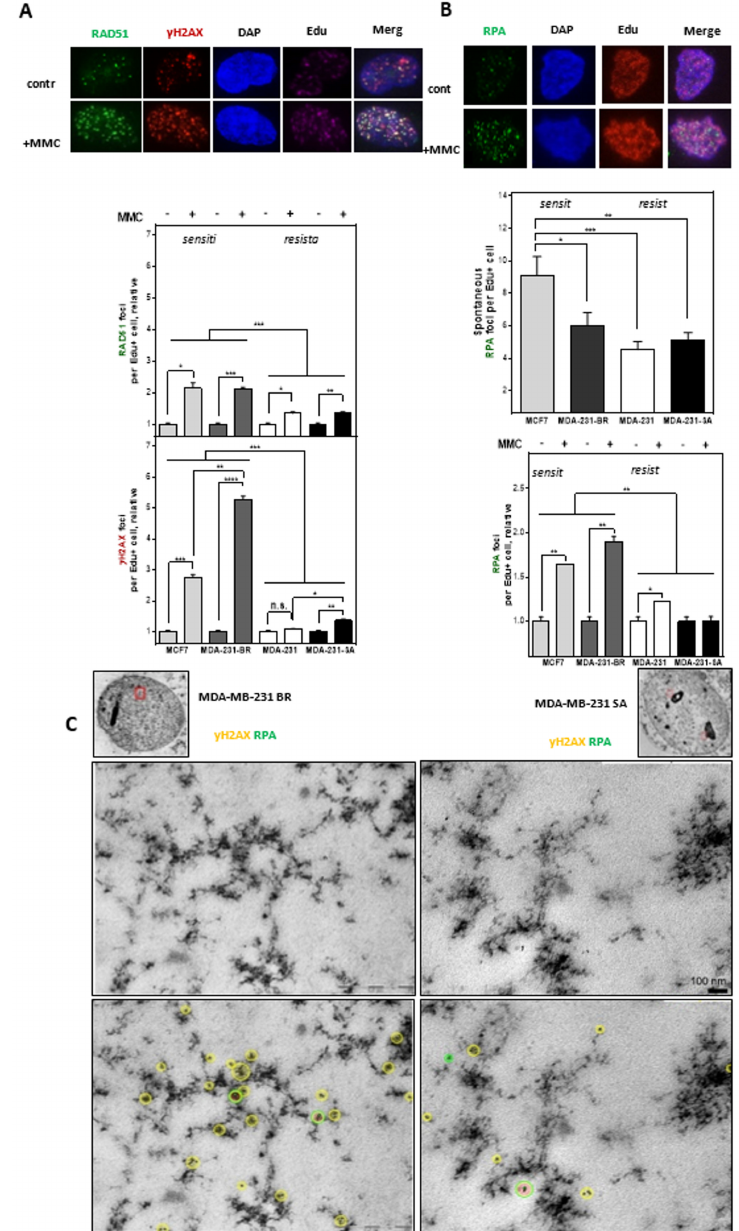
Figure 3. Resistance to MMC is due to the improved repair of DNA damage at DNA replication forks. ( A ) RAD51(green) and γ H2AX foci (red) as well as ( B ) RPA foci (green) in S-Phase (Edu + ) cells arising spontaneously or after treatment with MMC. Cells were treated with 0.5 µ g / mL MMC for 1 h after pulse labeling with 10 µ M Edu for 20 min. Immunofluorescent staining was performed 24 h after treatment with γ H2AX or RPA and fluorescent second antibodies. Replicating cells were discriminated by incorporated Edu stained with the “click-it” reaction. Foci analysis was done with the Image J Software. Foci were only counted in Edu-positive nuclei ( n = 100). DNA was counterstained by DAPI. The number of Foci was calculated relatively to the number of Foci in untreated control. Shown are means of three independent experiments ± SEM. Asterisks represent significant di ff erences (* p < 0.05; ** p < 0.01; *** p < 0.001; **** p < 0.0001, n.s. not significant; Student’s t-test). ( C ) Transmission electron microscopy shows colocalization of gold-labeled γ H2AX (yellow) and RPA (green) for MDA-MB-231 BR and MDA-MB-231 SA cells in untreated and MMC treated cells (0.5 µ g / mL) 24 h after treatment within nuclear ultrastructure mainly associated to heterochromatic